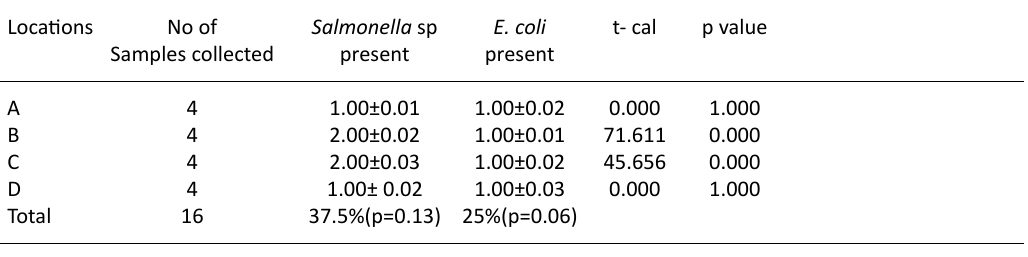
table 4. Percentage Occurrence of Some Enterobacteriaceae in Broiler Starter and Finisher Feeds Collected from Different Farms in Mando, Kaduna Locations No of Salmonella sp E. coli t- cal p value Samples collected present